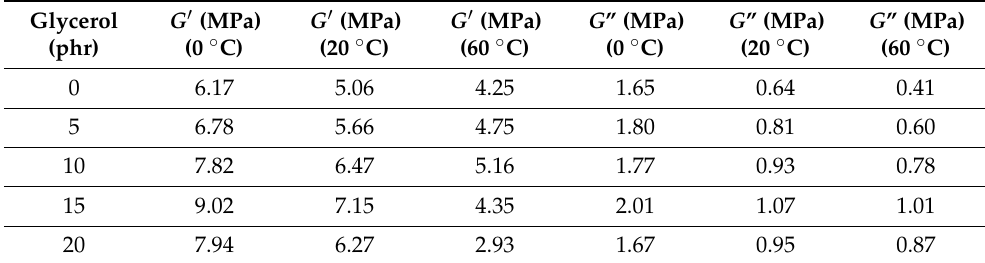
Table 1. Storage modulus ( G (cid:48) ) and loss modulus ( G ”) for vulcanizates based on SBR at different temperatures.